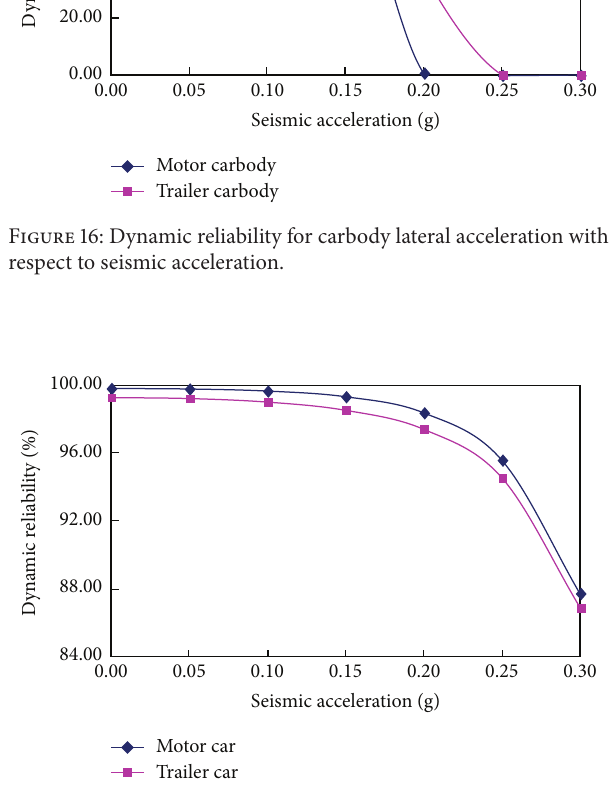
Figure 20: Dynamic reliability for carbody lateral acceleration with respect to pier